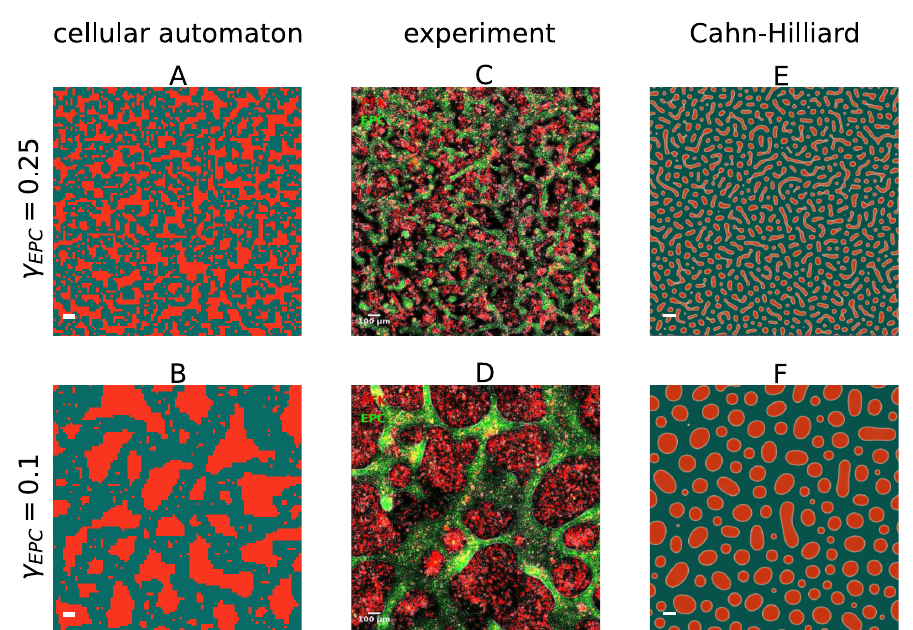
Fig 3. The cellular automaton reproduces morphology and size distribution of the cell clusters in the experiments of Me´hes et al. [20] of EPC (green) with PFK (red) closer than the Cahn-Hilliard model. The snapshots of the cell mixtures A, C, E of the first row are taken at a segregation index of EPC γ EPC = 0.25, at the start of the experimental recording, while the snapshots B, D, F in the second row are at a segregation index of EPC γ recording. A and B show the cellular automaton, C and D show the experiments and are taken from video S5 in Me´hes et al. [20], and E and F show the Cahn-Hilliard model. The snapshots A, B, E and F show a detail from the simulations, such that approximately 100 2 cells are visible, to match the spatial scale of the snapshots C and D of the experiments. The time points corresponding to the images are marked by black crosses in Figs 1 and 2.